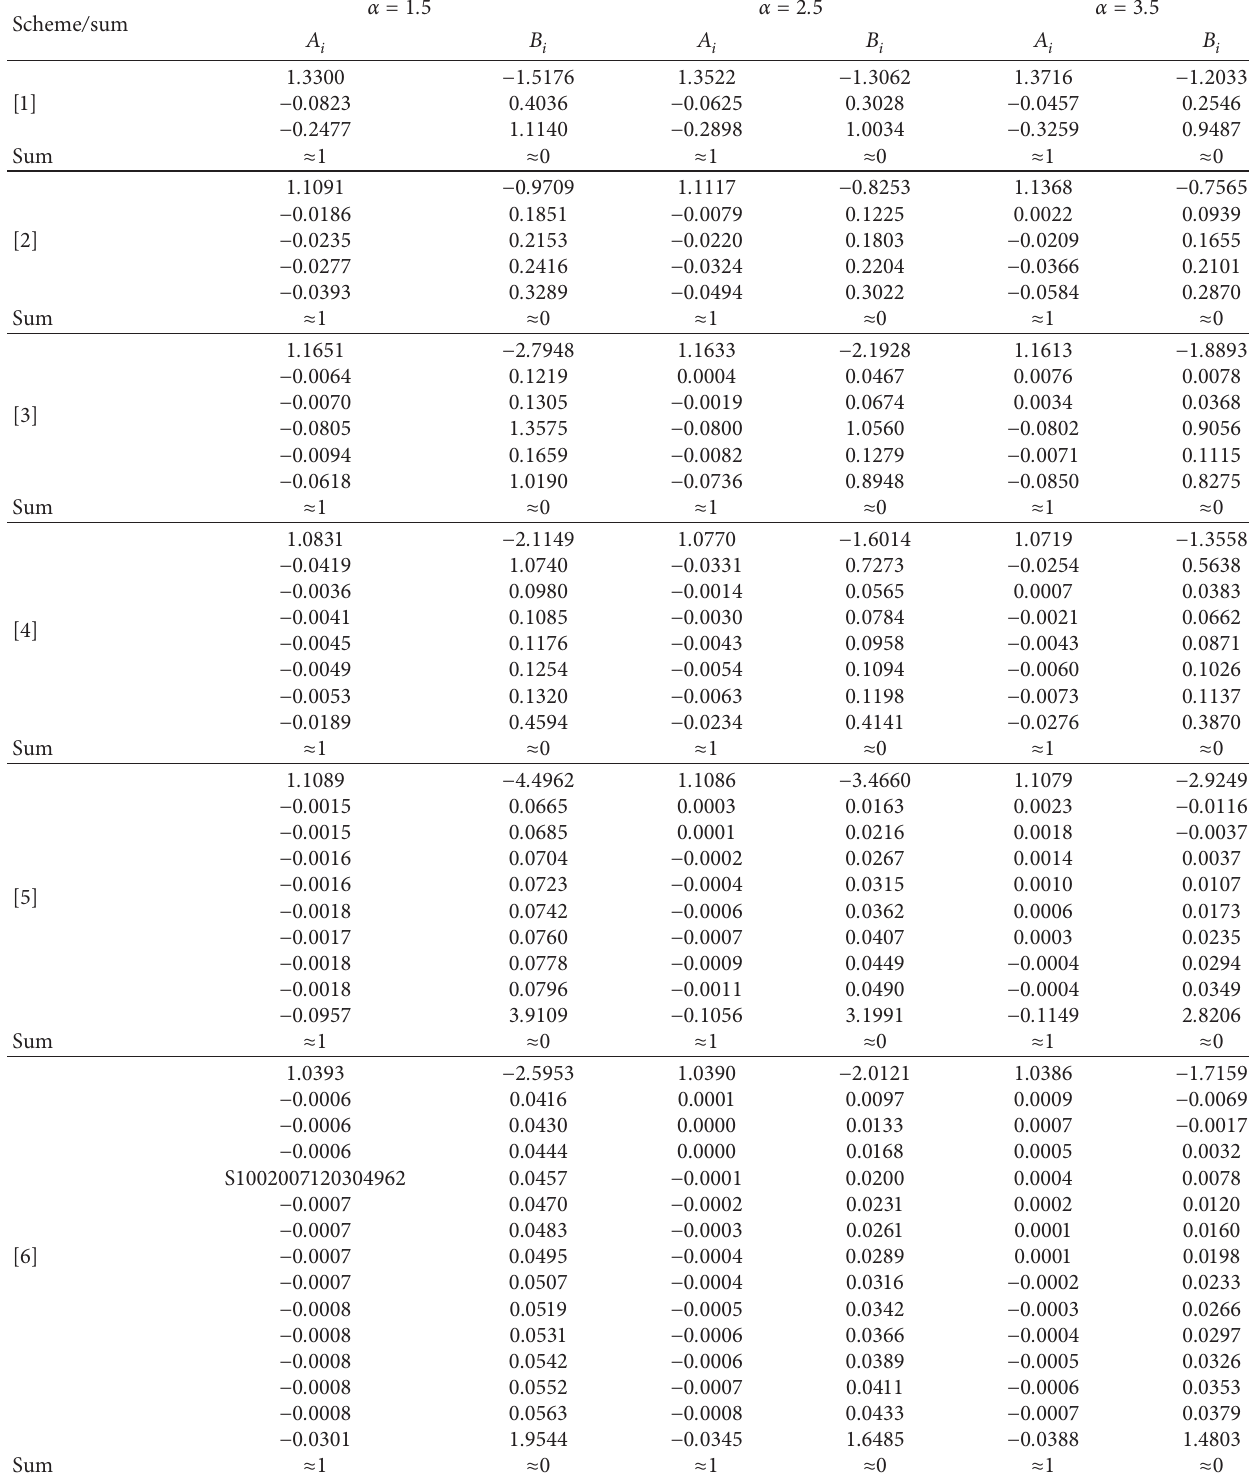
Table 1: Coefficients of ABLUEs of μ and λ from APE